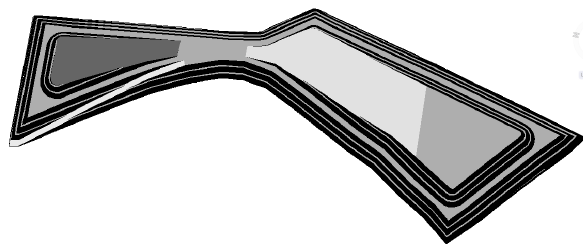
Figure 5: Surveying ("outbound") map of the field of the quarters marked 4A (Karmolińska – Słotkowska, 2013)